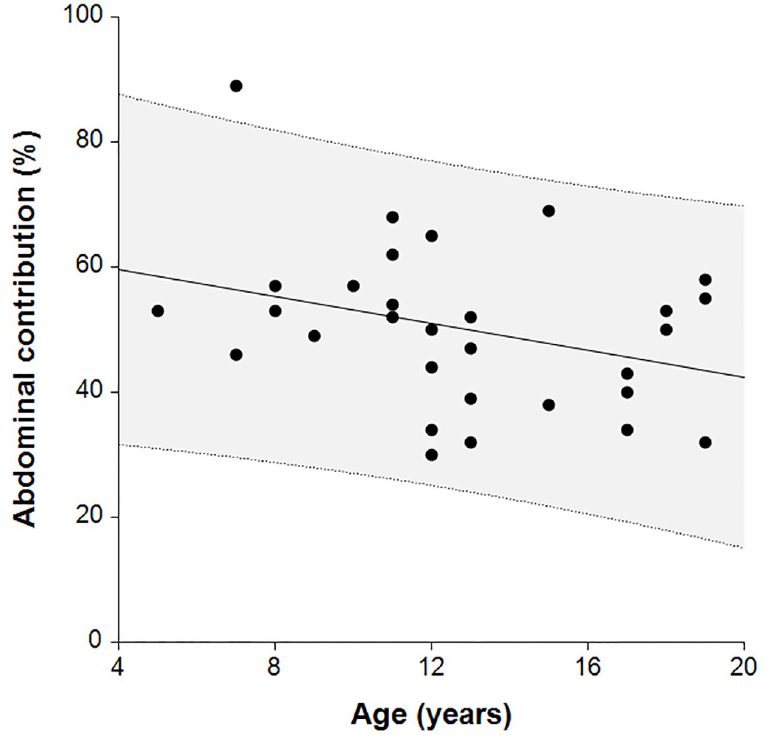
Fig 12. DMD patients reducing abdominal contribution with increasing